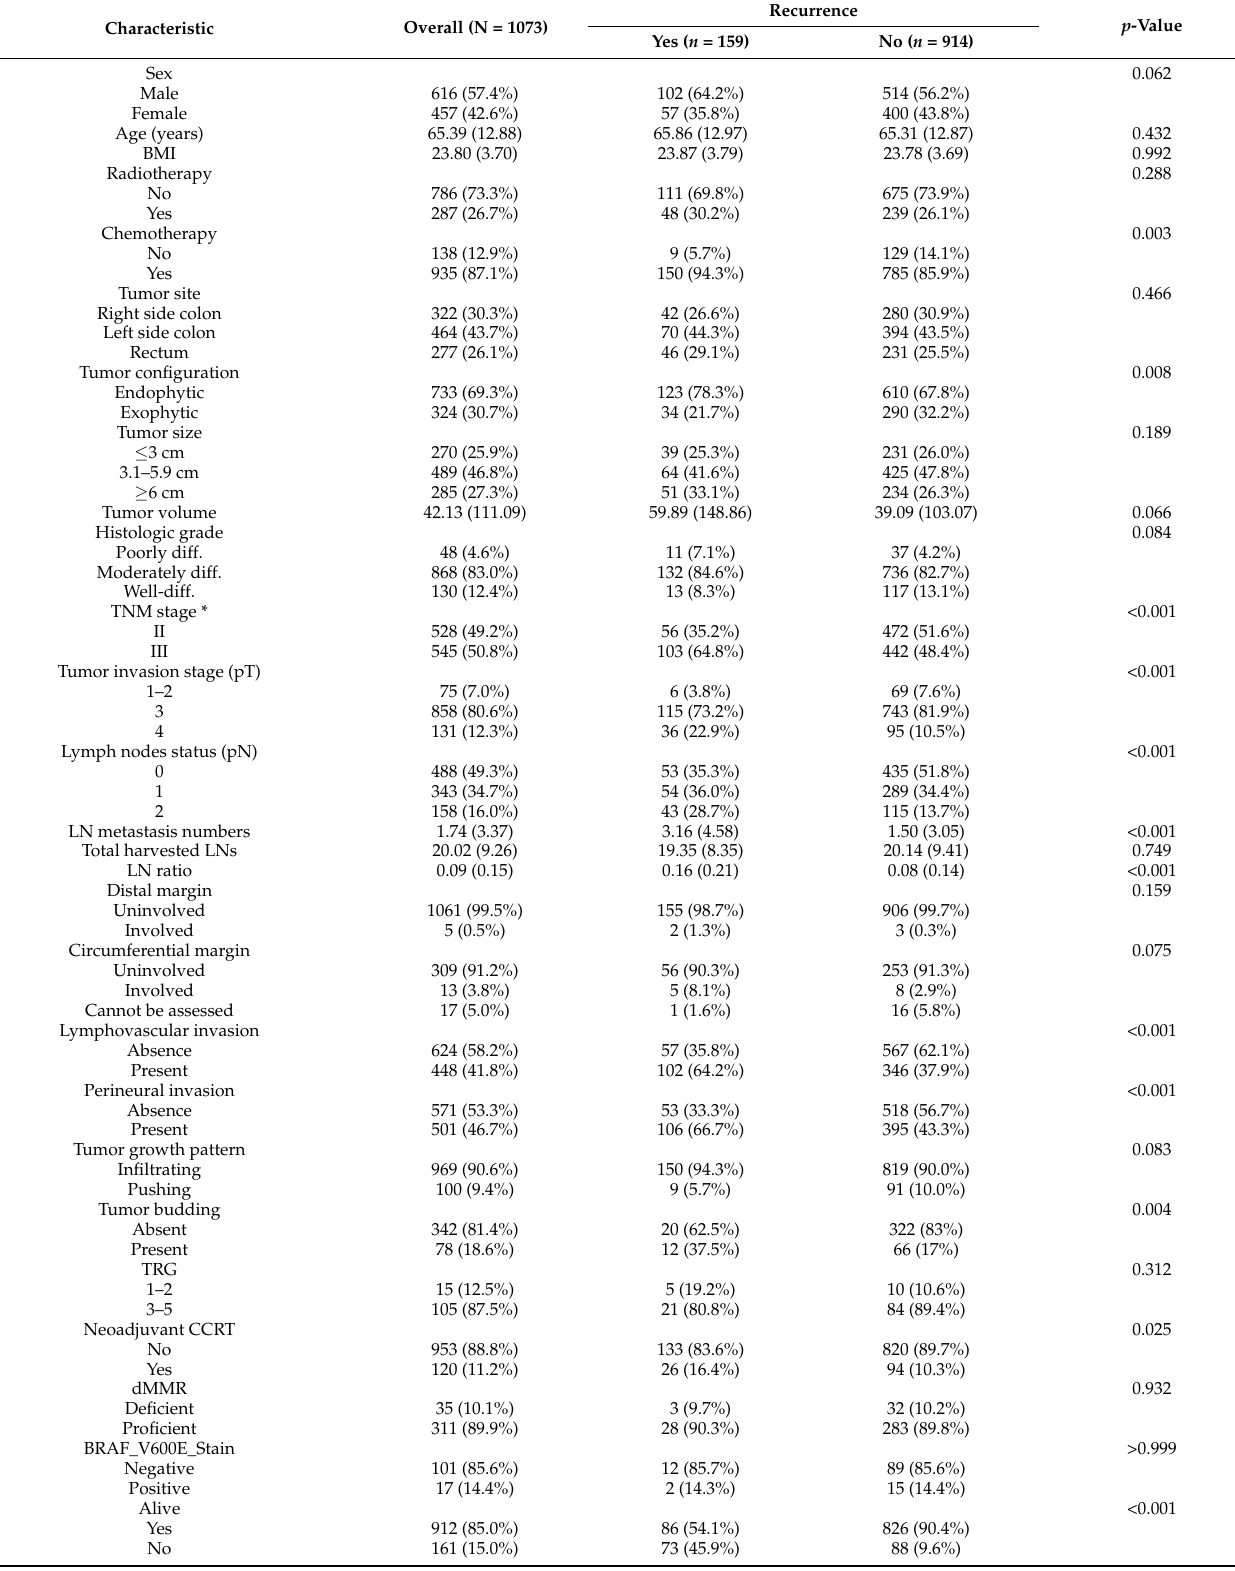
Table 1. Characteristics of patients with stage II and III colorectal